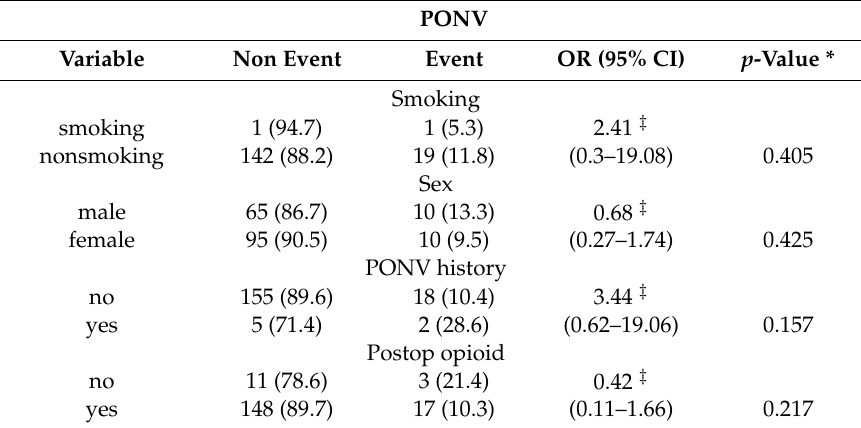
Table 6. PONV risk factors associated with PONV.